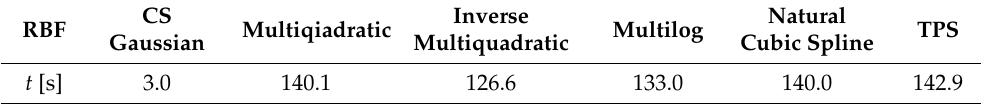
Table 4. Model building times and estimation errors of the test function for Gaussian CS-RBF and other models included in the Surfer program.